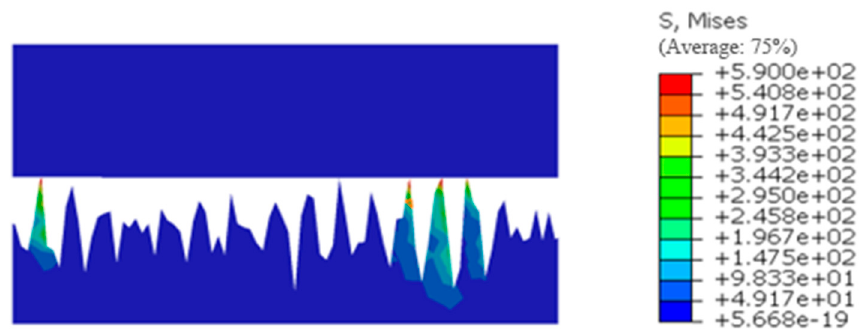
Figure 7. Schematic diagram of tangential stress concentration of some models.